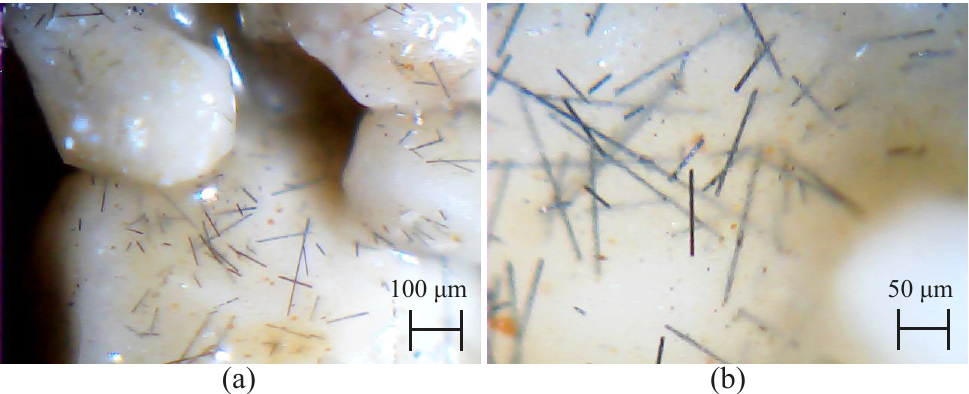
Figure 2. The dispersion of CMF inside EVIzero matrix: ( a ) CMF together with aggregates inside EVIzero; ( b ) zoomed view.